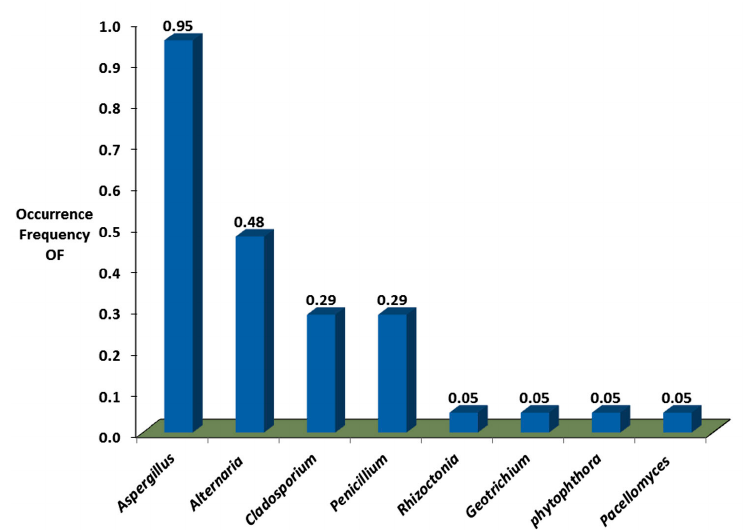
Fig. 1. Occurrence Frequency (OF) for fungi genera population isolated from faculty